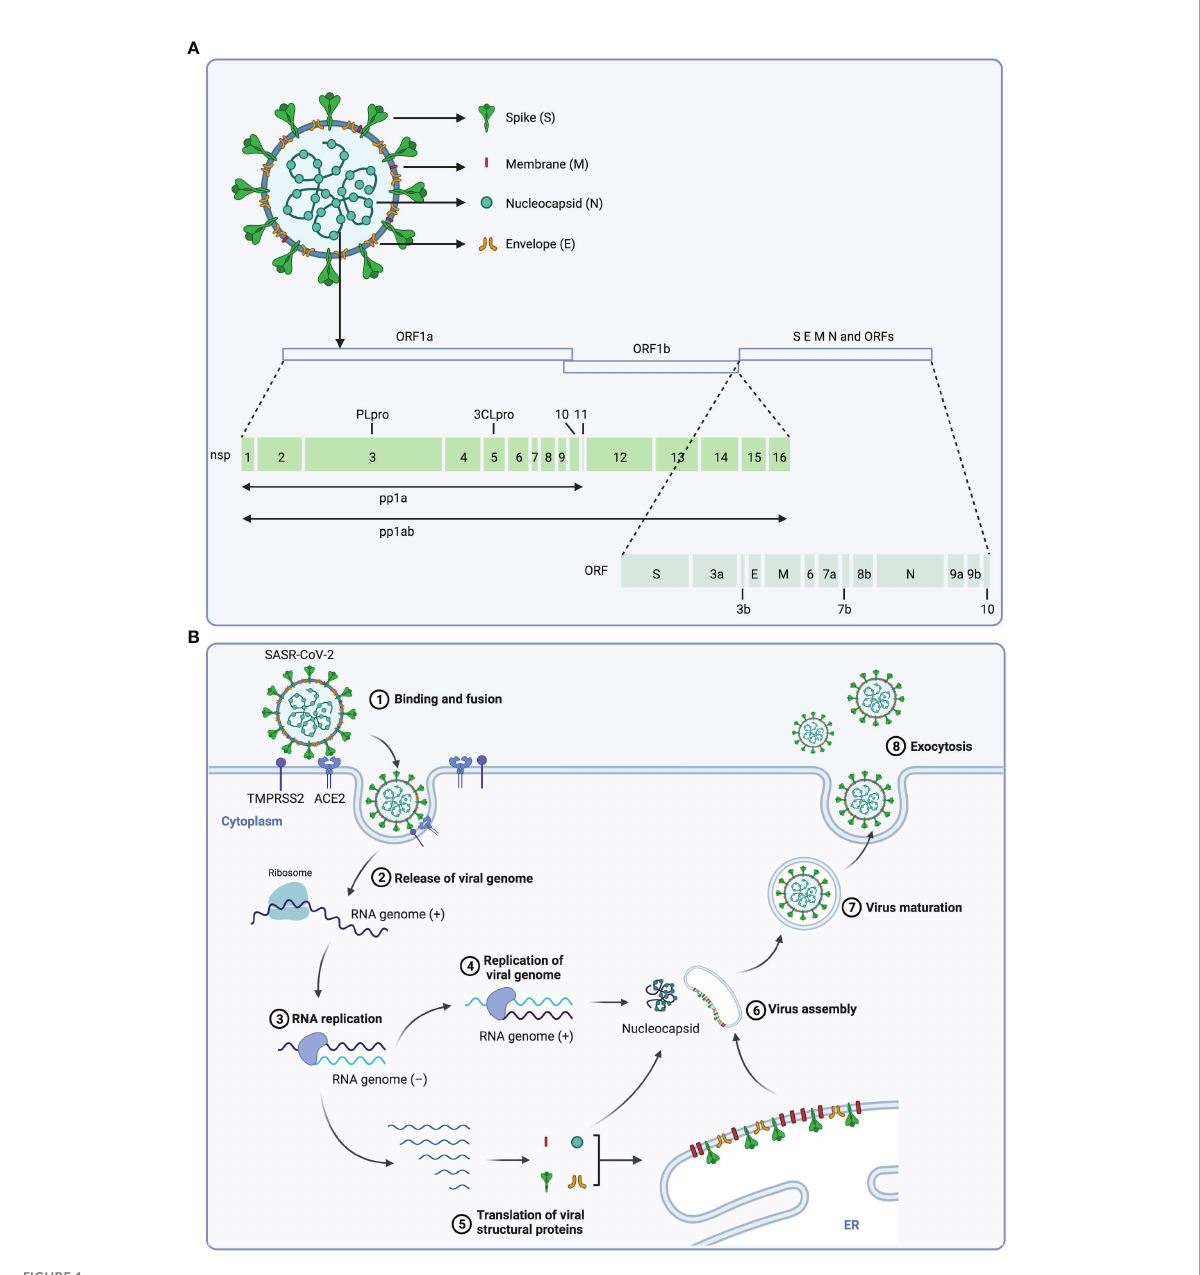
FIGURE 1 The structure and life cycle of SARS-CoV-2 virus. (A) The structure and genome of SARS-CoV-2 virus. The SARS-CoV-2 virus is composed of four structural proteins (spike protein S, membrane protein M, envelope protein E, and nucleocapsid protein N) and a single-stranded RNA genome. The virus genome contains 14 ORFs encoding 16 nonstructural proteins, 4 structural proteins and 9 accessory proteins respectively. (B) Scheme of the SARS-CoV-2 replication cycle. At the initial step of infection of this virus, the S1 subunit of the S protein interacts with the receptor angiotensin-converting enzyme 2 (ACE2) of host cells, and the S2 subunit is cleaved by TMPRSS2, a serine protease on the host cell surface, to promote uptake and fusion. Subsequently, the viral RNA is released into the cytoplasm of the host cell, and the ORF1a and ORF1b at the 5 ’ -end are translated to polyproteins (pp1a and pp1ab), which is then cleaved by viral proteases 3CLpro and PLpro to 16 nonstructural proteins (nsps). These nsps form the replication and transcription complex to synthesize progeny viral genomic RNA. In parallel, ORFs at 3 ’ -end are translated to structural proteins, and the S, M and E proteins are translocated to the ER-to-Golgi compartment, where they are assembled with N-encapsulated genomic RNA and then secreted out of cell through